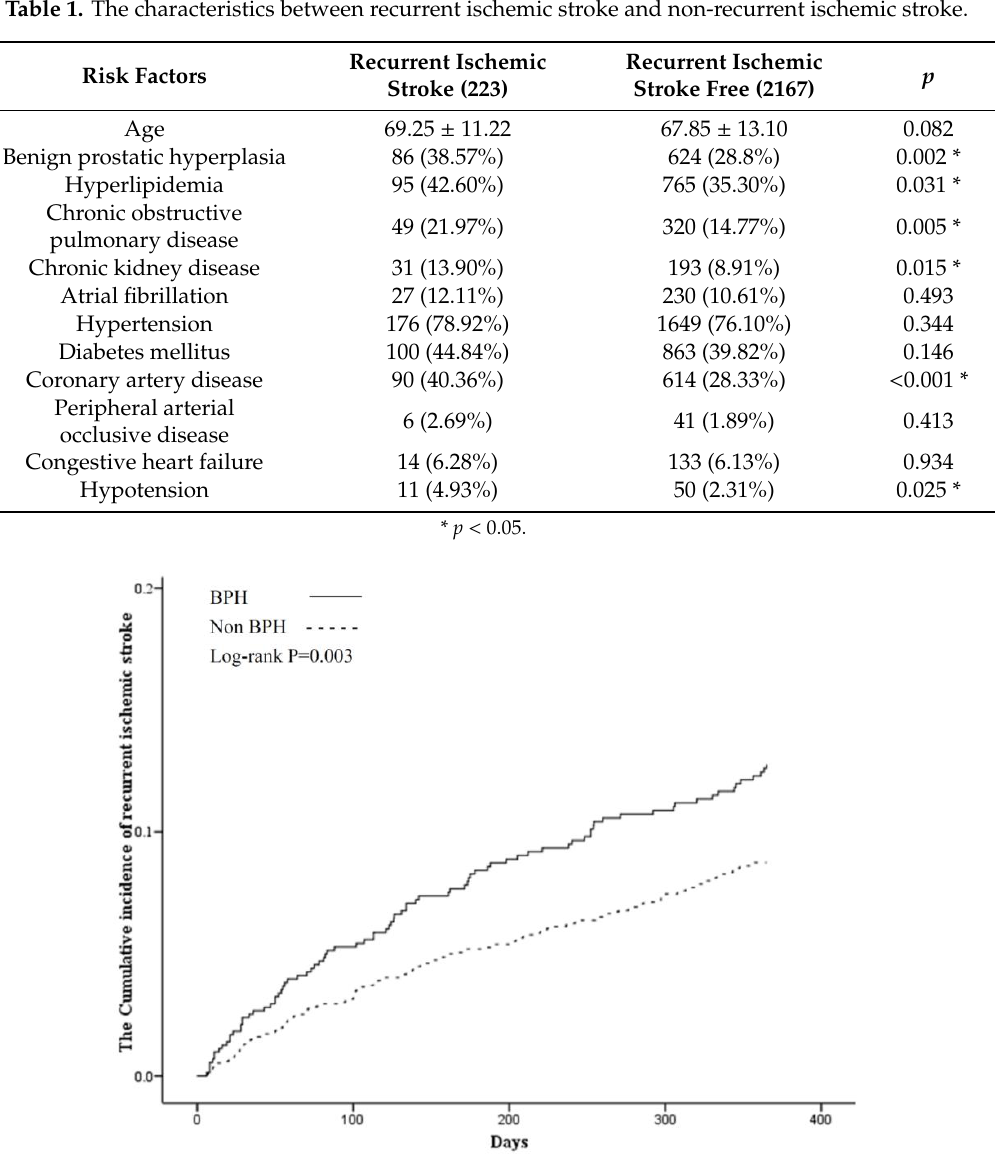
Figure 2. Kaplan–Meier curve for cumulative incidence of one-year recurrent ischemic stroke stratified by benign prostatic hyperplasia using the log-rank test. BPH: benign prostatic hyperplasia. Table 1. The characteristics between recurrent ischemic stroke and non-recurrent ischemic stroke.